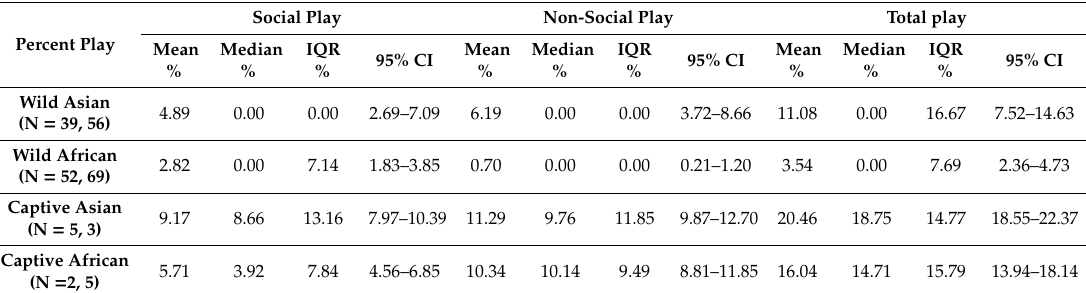
Table 5. Mean, Median, Interquartile Range (IQR) and 95% Confidence Interval (CI) for percentages of total activity budget spent in social, non-social and total play for calves < 24 months, by context. Total N male, N female sampled in